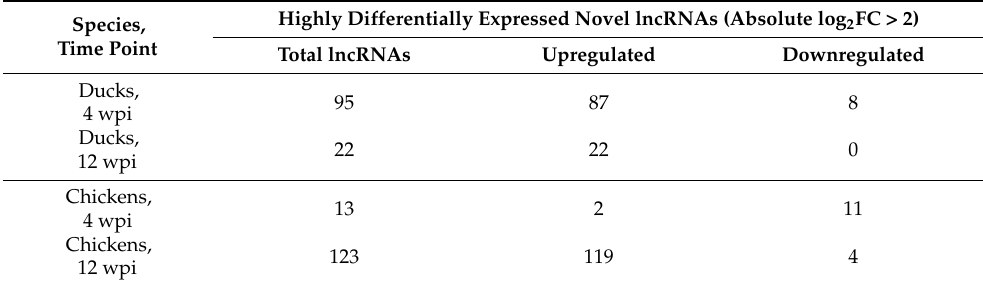
Table 5. Total highly differentially expressed novel long non-coding RNAs (lncRNAs) in the brains of ABBV-1 infected Muscovy ducks and